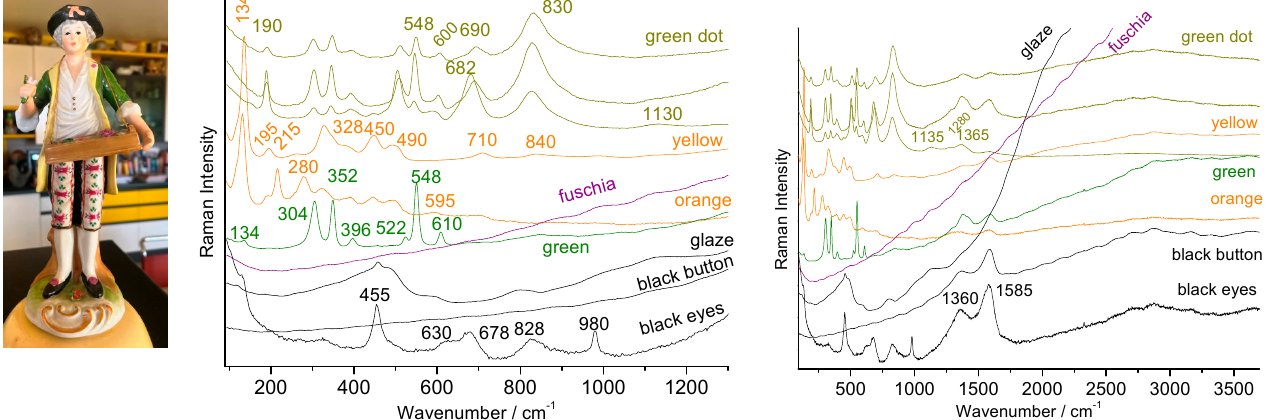
Figure 9. Representative Raman spectra recorded on porcelain figure from the end of the 19th century or beginning of the 20th century (unknown German factory); a zoom of the spectra below 1300 cm − 1 is given on the left; colored areas are given.